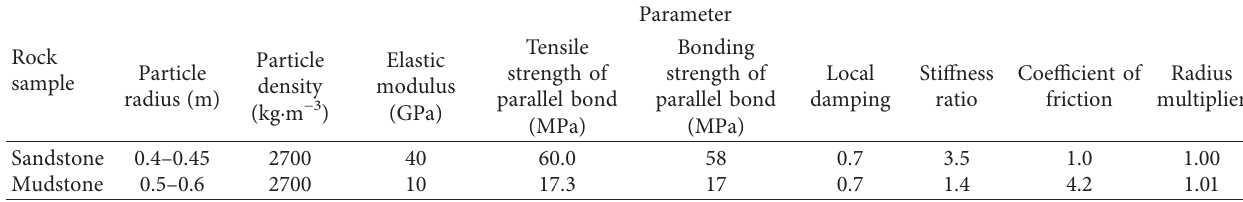
Table 2: PFC mesoscopic parameters of rocks.